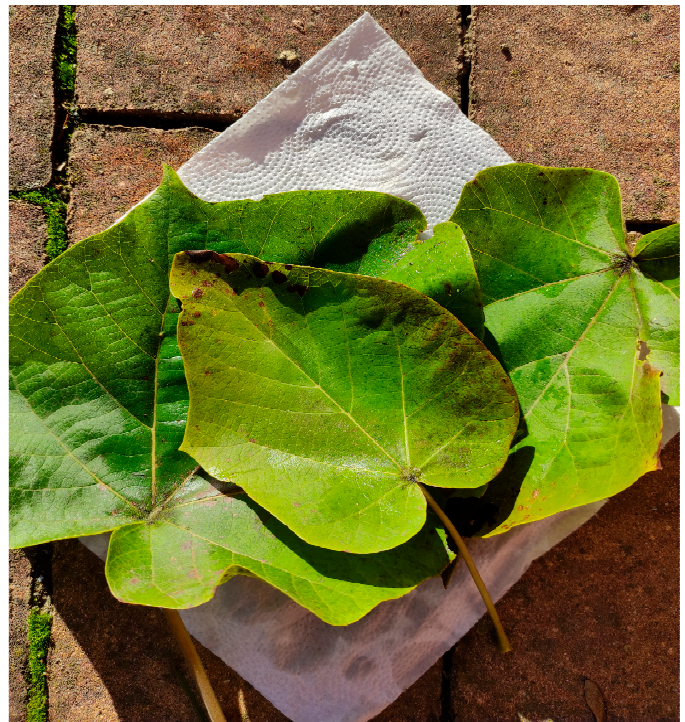
Figure 2. Pictures of leaves from the harvest “Growing”.